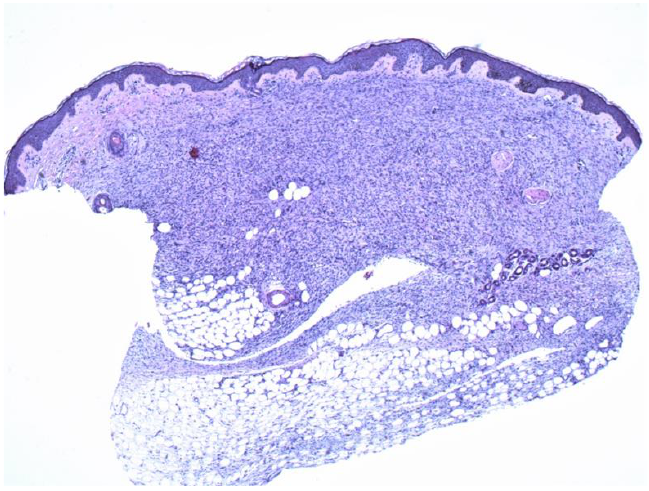
Figure 5. The second biopsy shows diffuse and even involvement of the dermis (4×).